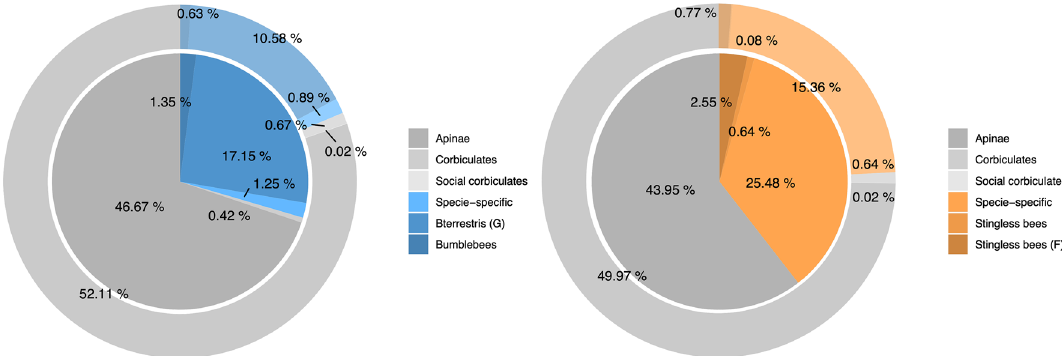
Figure 1. Proportion of conserved and taxonomically restricted orthogroups in B. terrestris (left) and T. angustula (right) transcriptomes. Inner circles represent the proportion within the differentially expressed genes between nurses and foragers, and outer circles show the proportion in the entire transcriptome. Gray shades represent classes of more taxonomically conserved orthogroups, and shades of blue and orange represent taxonomically restricted